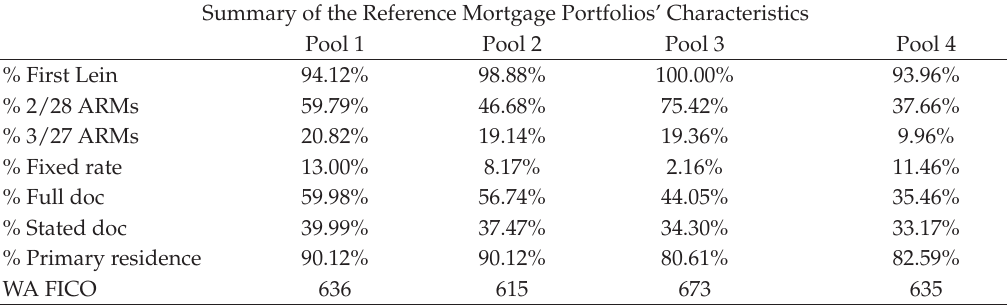
Table 7: Summary of the reference mortgage portfolios’ characteristics; source: (cid:6) 3 (cid:7)